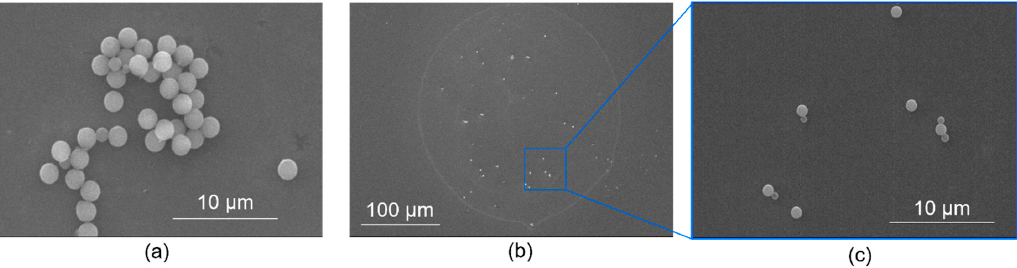
Figure 8. SEM images of particle-imprinted bulk silicon samples. ( a ) Partial segment of spherically shaped PMMA particles adsorbed on hydrophilic surfaces, ( b , c ) respectively depict a whole and magnified partial segment of PMMA particles adsorbed on a hydrophilic silicon surface. The particle-imprinting process was accomplished using a stainless-steel dispensing tip of inner/outer diameter ≈ 0.117/0.236 mm with a contact time of about 1 s.